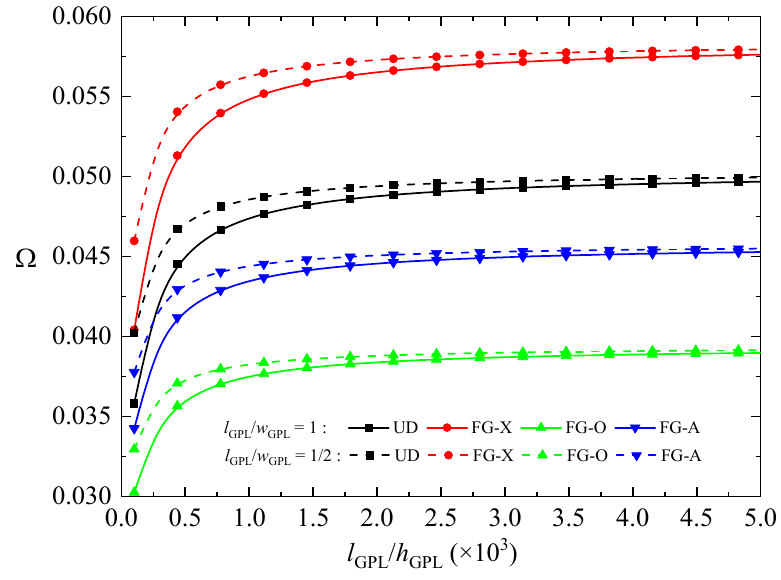
Figure 6. The fundamental frequency of S-S FG-GPLRC circular arch against the GPLs length-to-thickness ratio ( θ 0 = π/3, λ = 1/10).